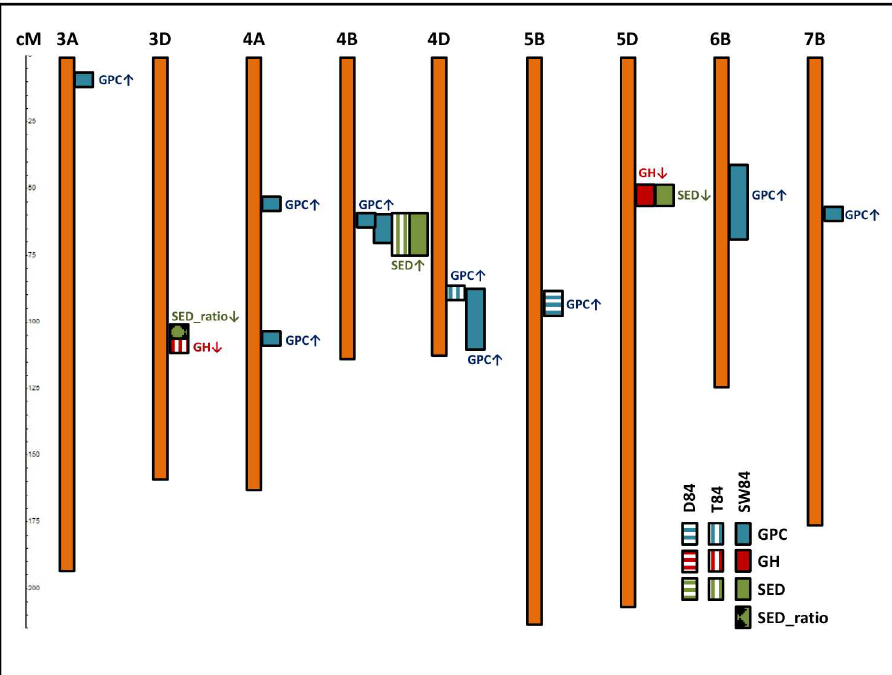
Fig 3. SNP map in cM locating 16 QTL for six traits detected across (SW84) and within families (D84 and T84). Trait abbreviations: GPC (Grain protein content), GH (grain hardness)and SED (sedimentation value), SED_ratio (sedimentation ratio, calculatedbetweenN0 and N1 levels). Arrowheadspointingup and down indicate increasing and decreasing trait effects of exotic QTL